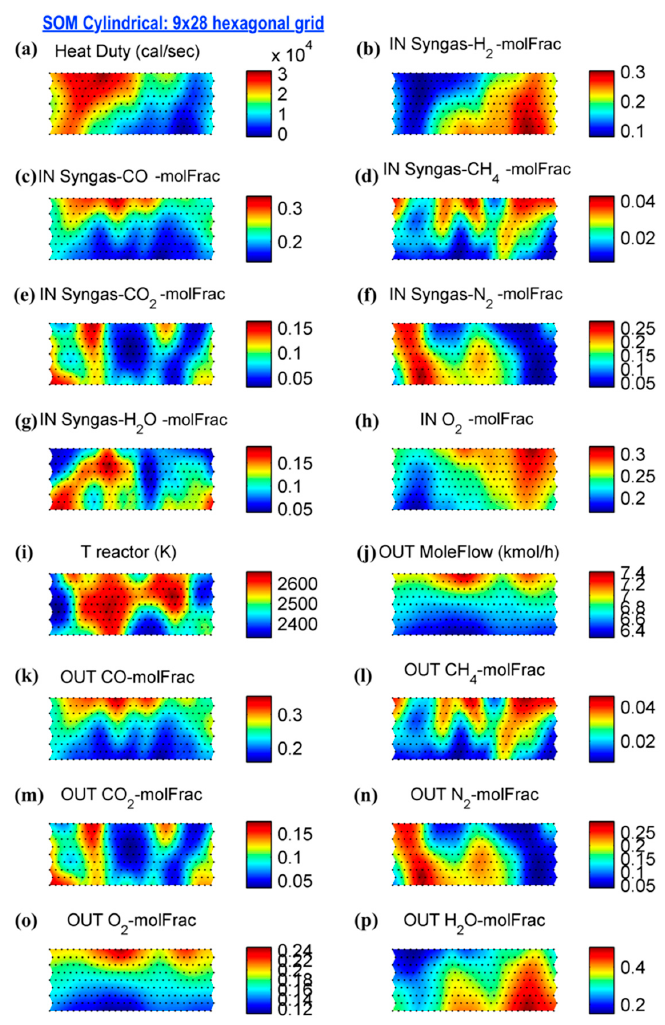
Figure 9. Surface projection of the system variables modelled through cylindrical SOM consists of neurons in hexagonal pattern of nine grid rows x 28 grid columns. ( a ) Process heat duty (cal / sec); ( b )– ( h ) mole fraction of chemical species in the feed; ( i ) reactor temperature; ( j ) total molar out flow from reactor; ( k )–( p ) mole fraction of chemical species in the reactor outflow stream.